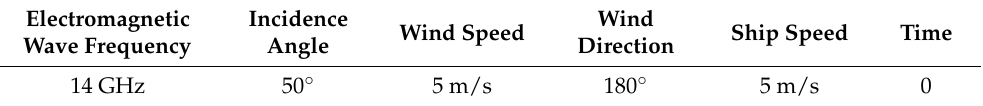
Figure 9. Bistatic scattering coefficients ( a ) for HH polarization and ( b ) for VV polarization. Table 3. Parameters used to calculate the bistatic scattering